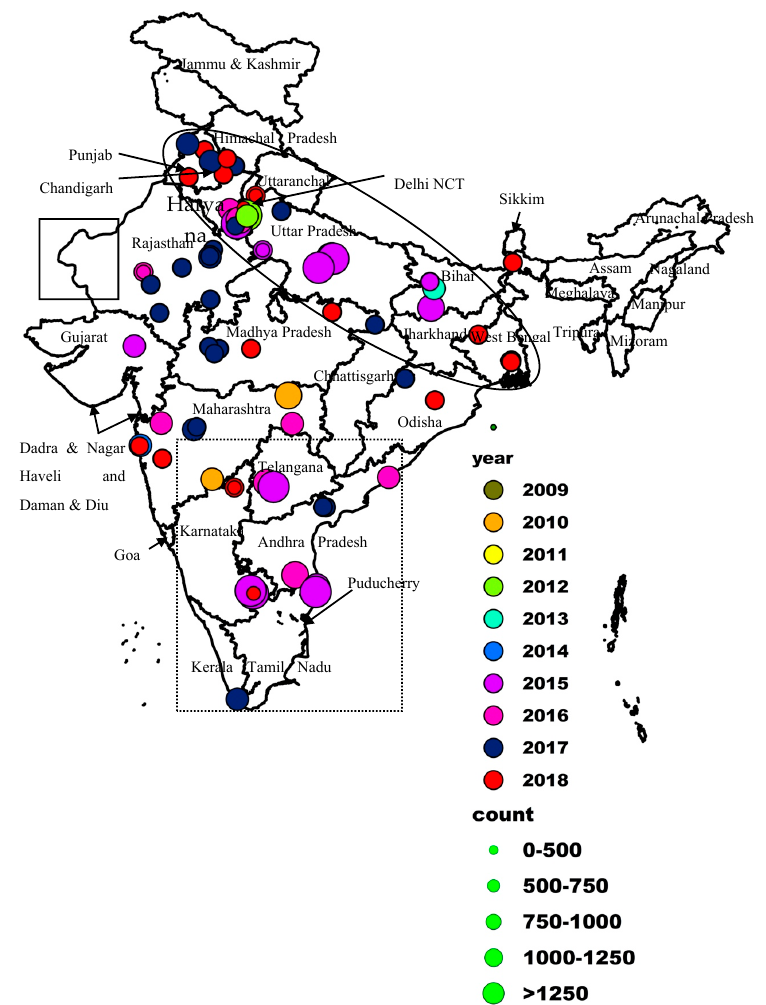
Figure A1. Central Pollution Control Board monitoring sites that are used to calibrate the satellite-PM 2.5 dataset. The location of the Indo–Gangetic Plain, IGP (as discussed in the main text) is demarcated by oval shape, the Thar Desert by the rectangular box and Peninsular India by a dotted box. The size of the circles indicates the number of data and the colors represent the year from which the measurements started in each site.